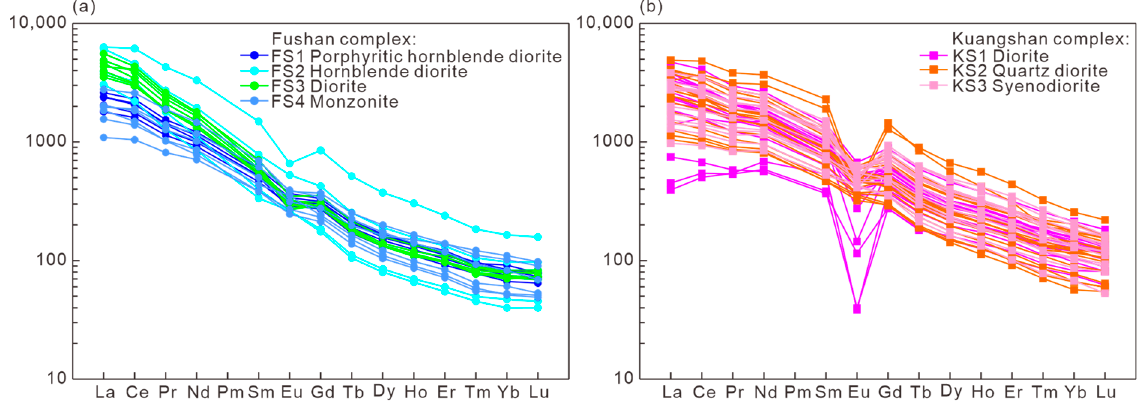
Figure 8. Chondrite-normalized REE distribution patterns of apatite. ( a ) Apatite from the Fushan complex; ( b ) Apatite from the Kuangshan complex. The chondrite REE values are from [72].